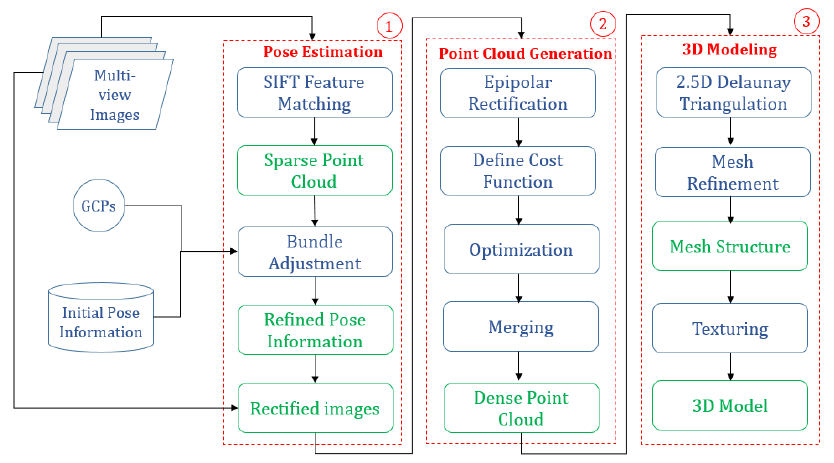
Figure 1. Workflow of 3D